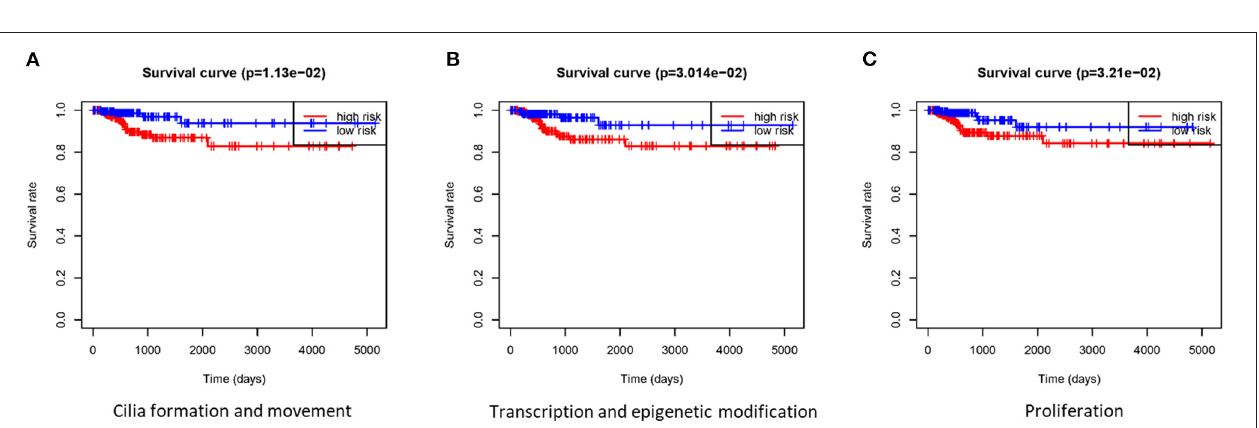
FIGURE 3 | The AUC of four signatures of metabolism, signal and substance transport, transcription and epigenetic modification, and extracellular matrix. (A–D) The AUC of the group metabolism, signal and substance transport, transcription and epigenetic modification, and extracellular matrix was > 0.75 in both the training set and validation set. AUC, area under the receiver operating characteristic curve.